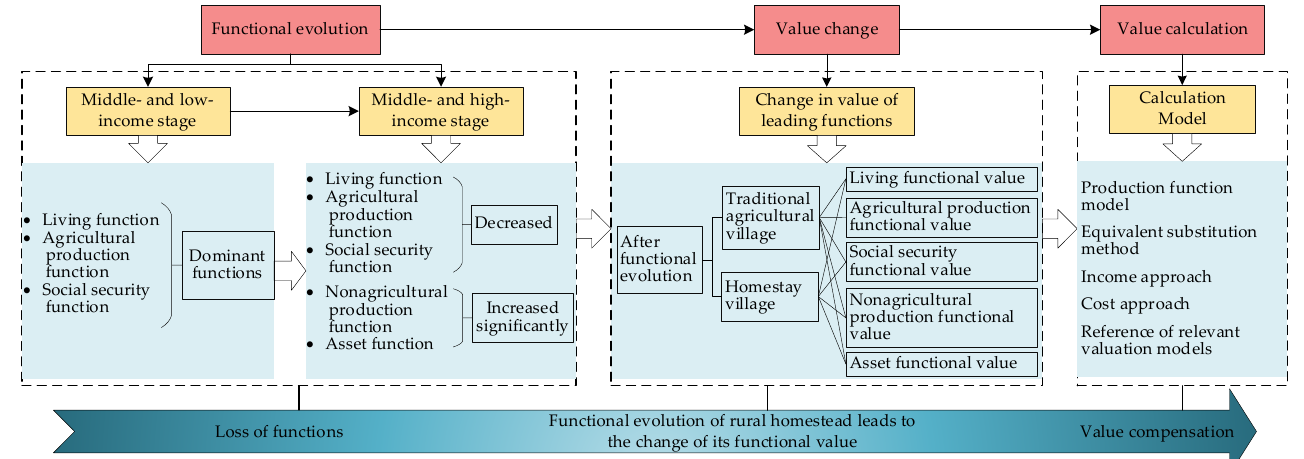
Figure 1. The analytical framework of rural homestead function evolution under the background of national economic income level change .